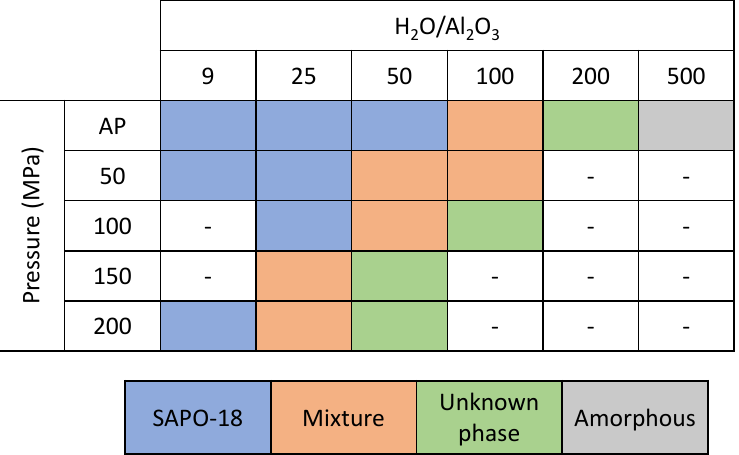
Figure 7. Products obtained with different synthesis mixture concentrations at 150 °C under AP, 50, 100, 150 and 200 MPa of external hydrostatic pressure.